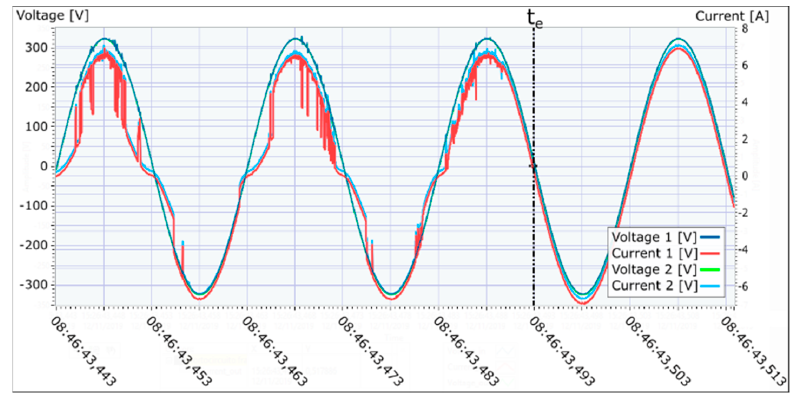
Figure 5. Instant ( t e ) at which the arc turned into a short circuit (using the Bourns 2049-07 surge arrester).